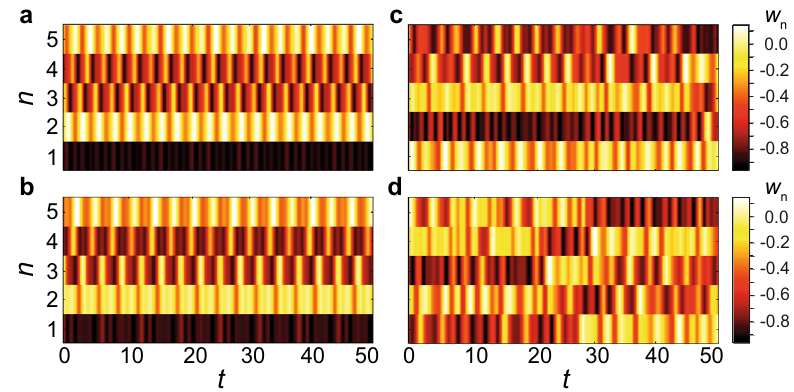
Fig. 3 Time evolution of w n for 5 qubits. a Periodic [ Δ = 3.74], b quasiperiodic [ Δ = 3.73], c chaotic [ Δ = 4.05], and d hyperchaotic [ Δ = 4.95] oscillations; n labels an qubit in the chain.